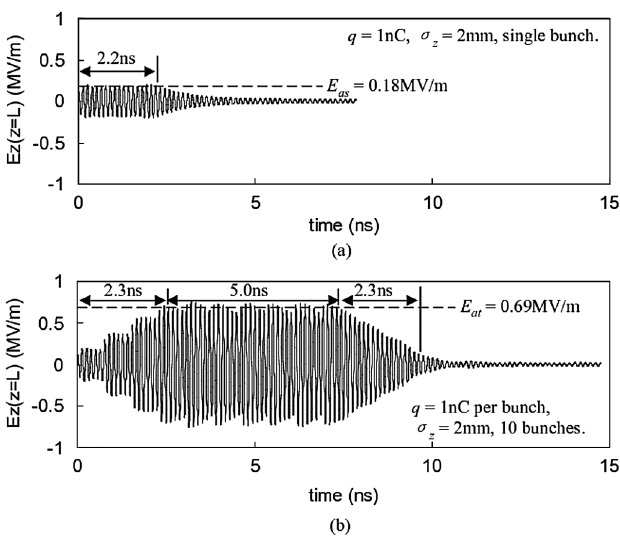
FIG. 5. MAFIA simulation of the gradient at the end of the decelerator induced by (a) a single bunch; (b) a train of 10